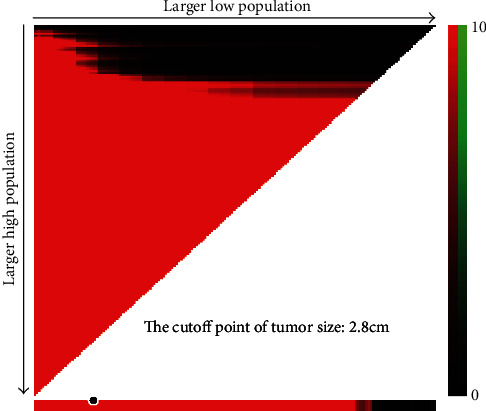
Division of tumor size by the cutoff point produced by the X-Tile plot.